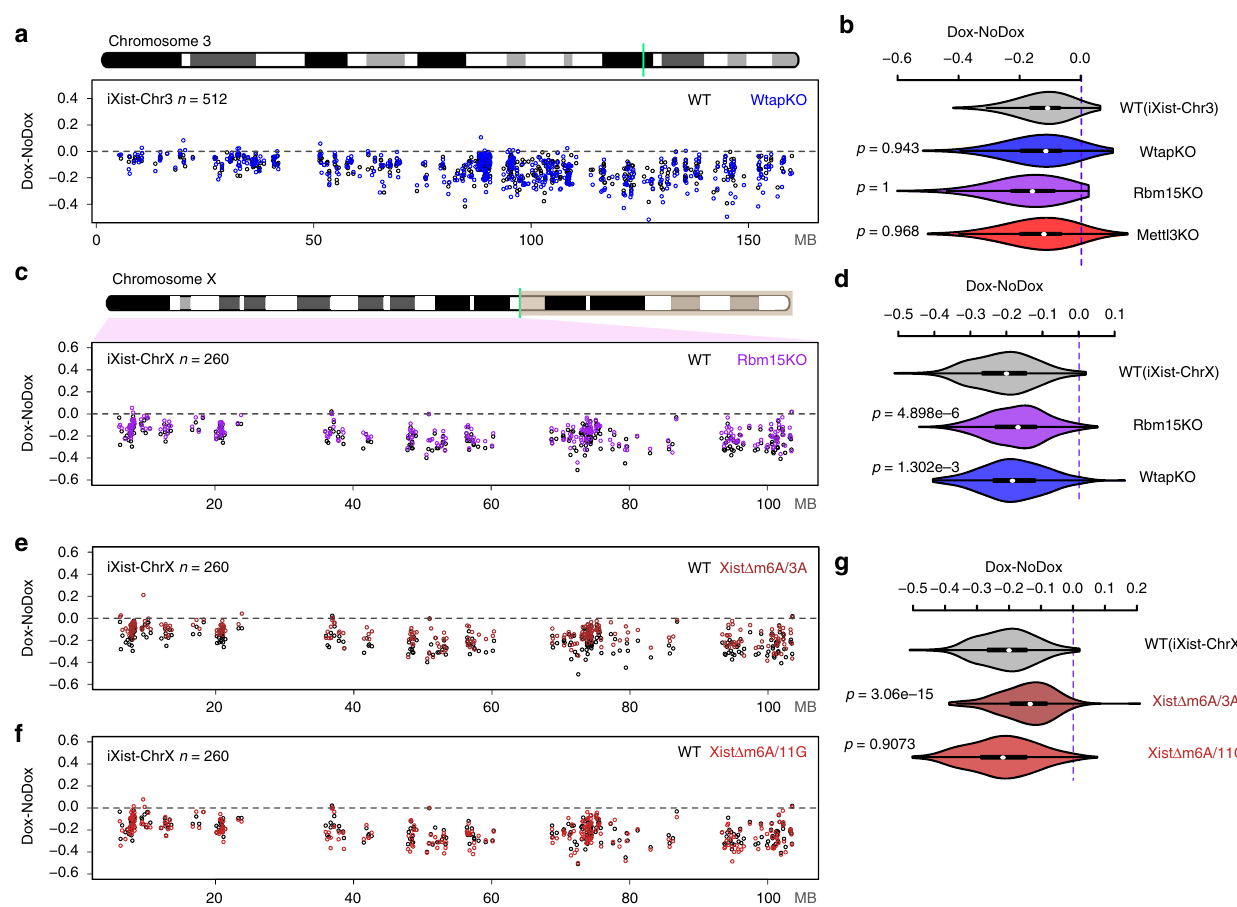
Fig. 3 The role of Rbm15/m6A-MTase complex in Xist-mediated silencing. a Allelic silencing across Chr3 after 1 day of Xist RNA induction in WT and Wtap null (KO) iXist-Chr3 cells. Mean value of difference of allelic ratio for each gene with an informative SNP was calculated from biological replicates as detailed in Supplementary Table 4. Green line on Chr3 ideogram indicates location of the Xist transgene. b Violin plot summarising data for Wtap null in a , and additionally, data for Mettl3 mutant and Rbm15 null shown in Supplementary Fig. 3c. P values were calculated using one-sided Wilcoxon rank-sum test. c Allelic silencing across ChrX after 1 day of Xist RNA induction in WT and Rbm15 null (KO) iXist-ChrX cells. Mean value of difference of allelic ratio for each gene with an informative SNP was calculated from biological replicates as detailed in Supplementary Table 4. Green line on ChrX ideogram indicates location of the Xist locus. d Violin plot summarising data in c . P values were calculated using one-sided Wilcoxon rank-sum test. e , f Allelic silencing across ChrX after 1 day of Xist RNA induction in WT and cell lines with deletions within the major m6A peak region, Xist Δ m6A/3A ( e ) and Xist Δ m6A/11 G ( f ) in iXist-ChrX cells. Mean value of difference of allelic ratio for each gene with an informative SNP was calculated from biological replicates as detailed in Supplementary Table 4. g Violin plot summarising data in e , f . P values were calculated using one-sided Wilcoxon rank-sum